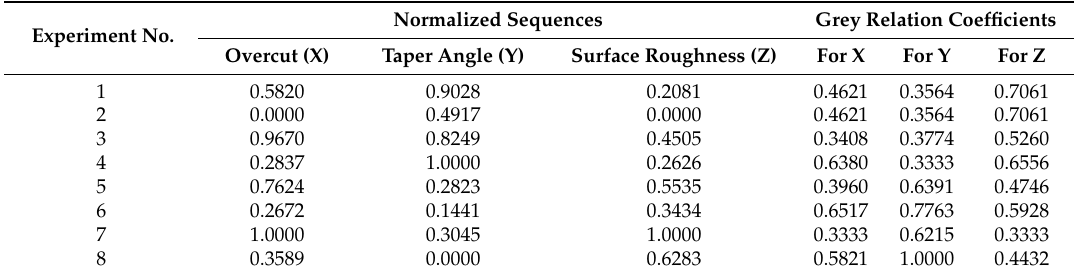
Table 6. Normalized sequences of S/N ratios and Grey relation coefficients. Experiment